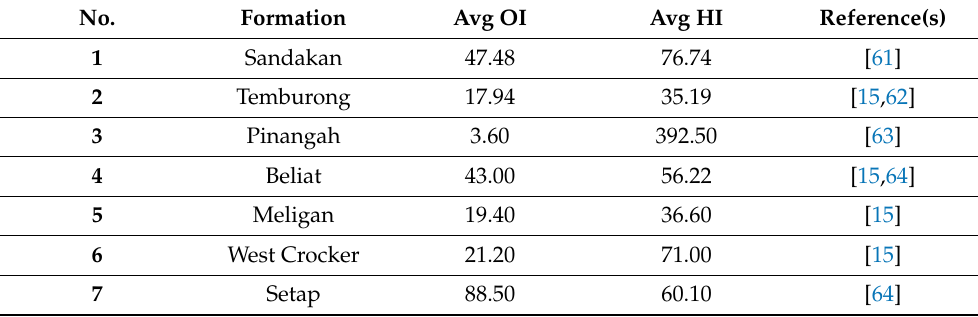
Figure 9. A plot of average S2 versus average TOC of formations in Sabah showing hydrocarbon yield potential and kerogen type. Table 9. Average OI and HI values of formations in Sabah.